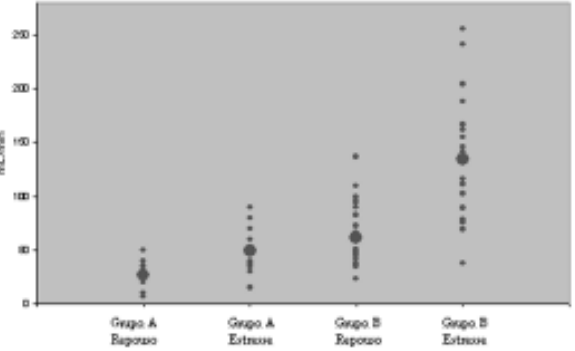
Fig. 4 - Dispersão dos valores dos débitos diastólicos (DD), em ml/min, nos grupos A e B, em repouso e em estresse. As médias dos valores dos DD foram ressaltadas.